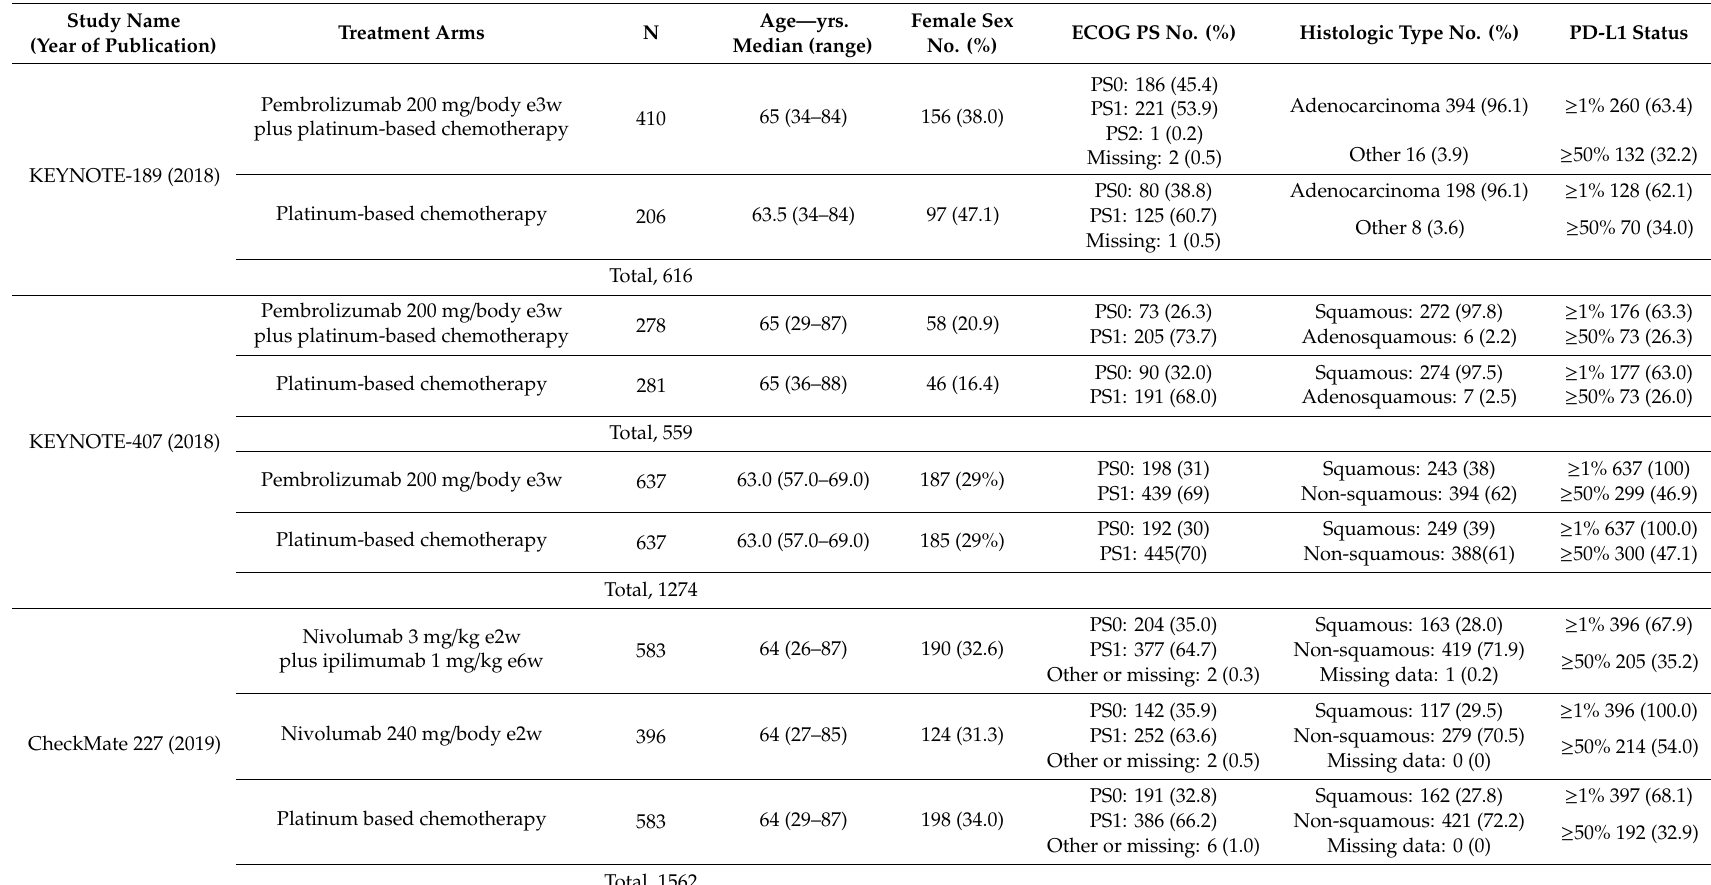
Table 2. Characteristics of the included